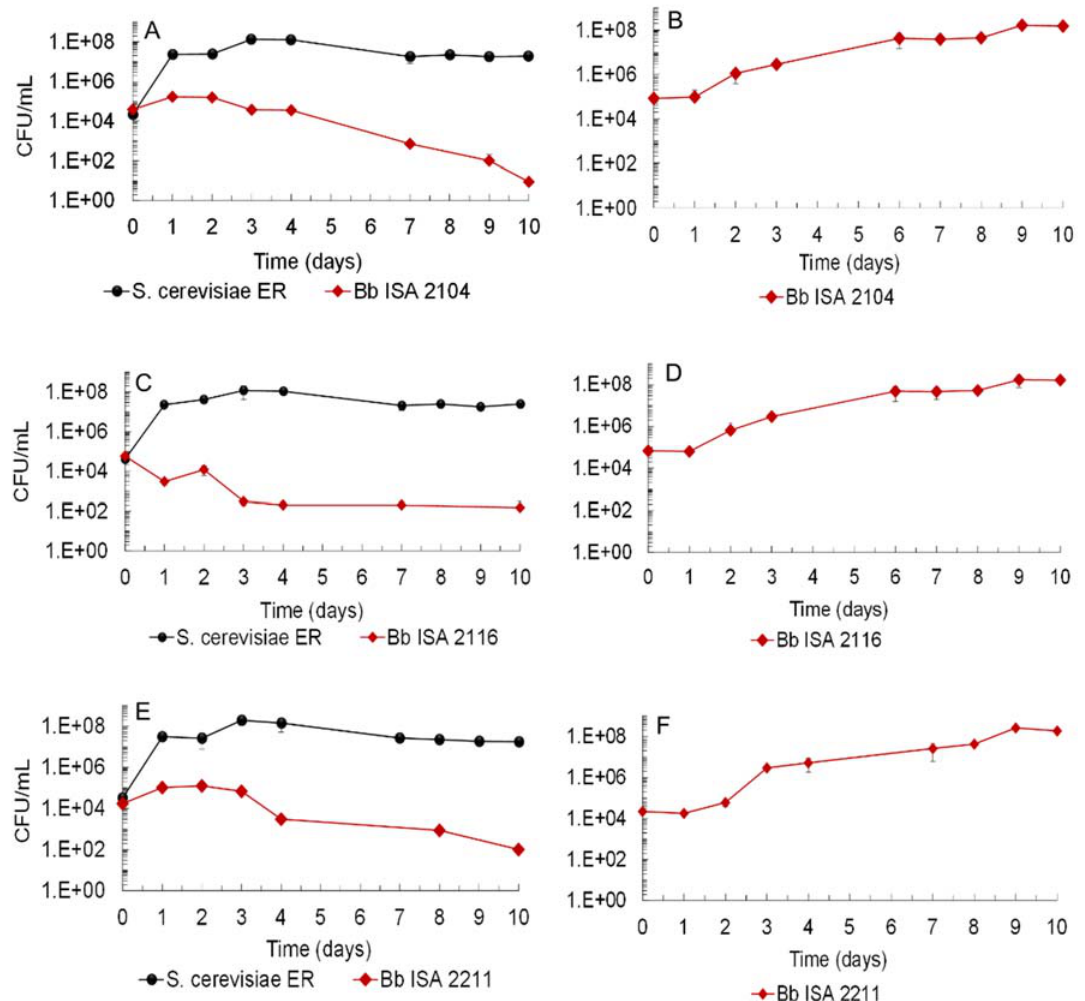
Figure 3. Culturability of S. cerevisiae ER and B. bruxellensis (Bb) during alcoholic fermentations performed with Bb strains ISA 2104 ( A , B ), ISA 2116 ( C , D ) and ISA 2211 ( E , F ) in mixed-culture with S. cerevisiae ER ( A , C , E ) and in single-culture ( B , D , F ). Data represented correspond to means ± SD (error bars) of two independent biological assays.